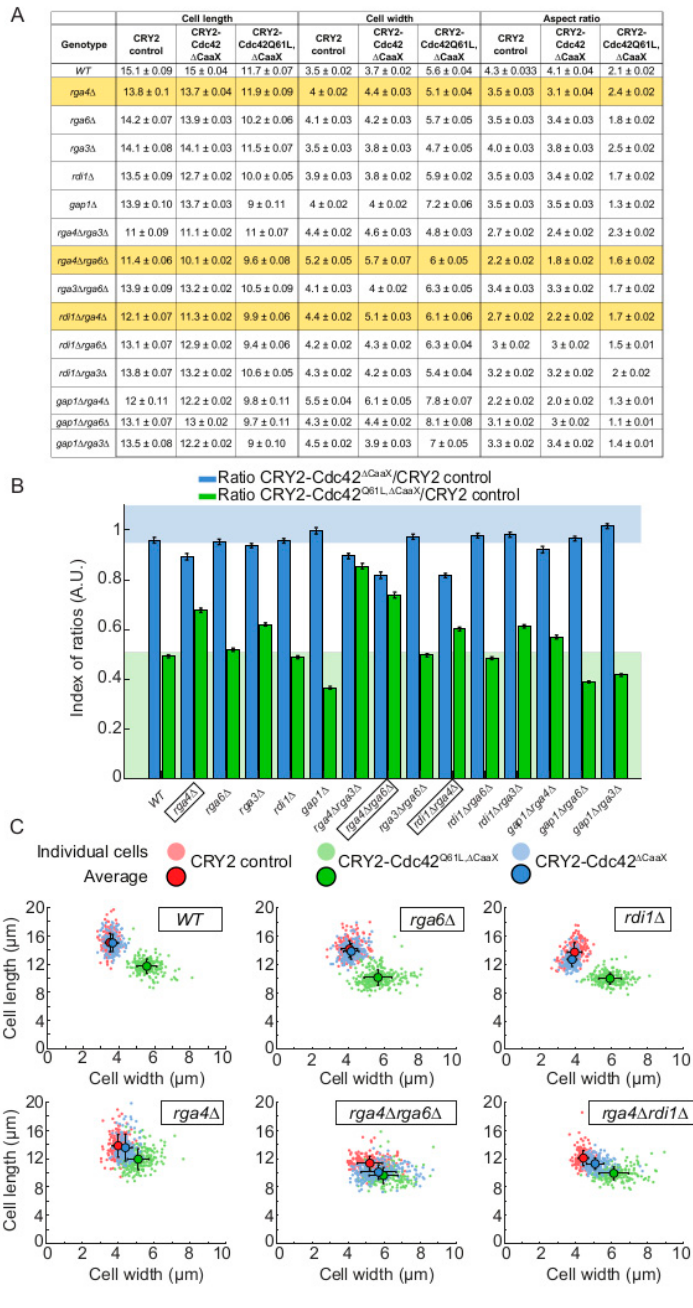
Figure 4. Rga4 GAP prevents growth on cell sides in CRY2-Cdc42 ∆ CaaX cells. ( A ) Average cell length ( µ m), cell width ( µ m) and aspect ratio of CRY2, CRY2-Cdc42 ∆ Caax and CRY2-Cdc42 Q61L, ∆ CaaX mutants. For all mutant N = 2, n > 80 cells per experiment; except for gap1 ∆ mutants, N = 1, n > 80 cells per experiment. ( B ) Aspect ratios of CRY2-Cdc42 ∆ Caax and CRY2-Cdc42 Q61L, ∆ Caax -expressing cells grown in the light normalized to the aspect ratios of CRY2-expressing cells for all the tested mutants. Bars = standard error. The green background indicates expected reduction in aspect ratio upon CRY2-Cdc42 Q61L, ∆ CaaX recruitment in WT cells. The blue background indicates absence of change in aspect ratio upon CRY2-Cdc42 Q61L recruitment. Note that all rga4 ∆ mutants fall in the white intermediate space. ( C ) Cluster plot of length and width in single cells of WT, rga4 ∆ , rga6 ∆ , rga4 ∆ rga6 ∆ , rdi1 ∆ and rga4 ∆ rdi1 ∆ mutants expressing CRY2, CRY2-Cdc42 ∆ Caax or CRY2-Cdc42 Q61L, ∆ CaaX . Small dots = single cells; Large, dark dots = average; bars = standard deviation; A.U., arbitrary units; WT, wild